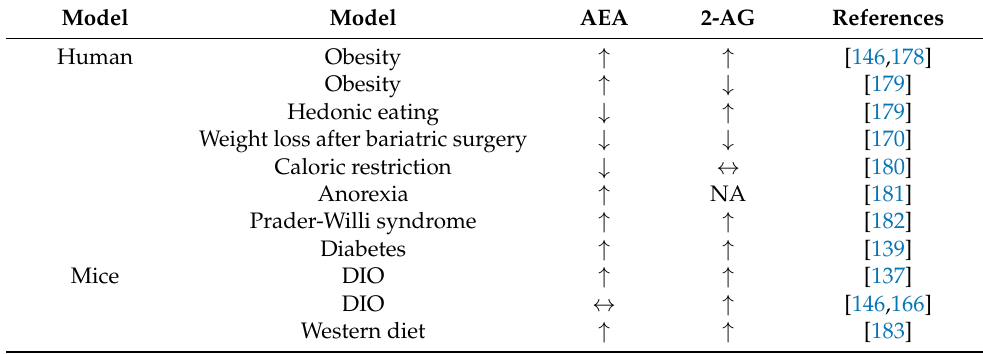
Table 2. Circulating level of endocannabinoids associated with obesity. AEA and 2-AG are detected in the plasma and are modulated according to the metabolic condition. DIO, diet-induced obesity.